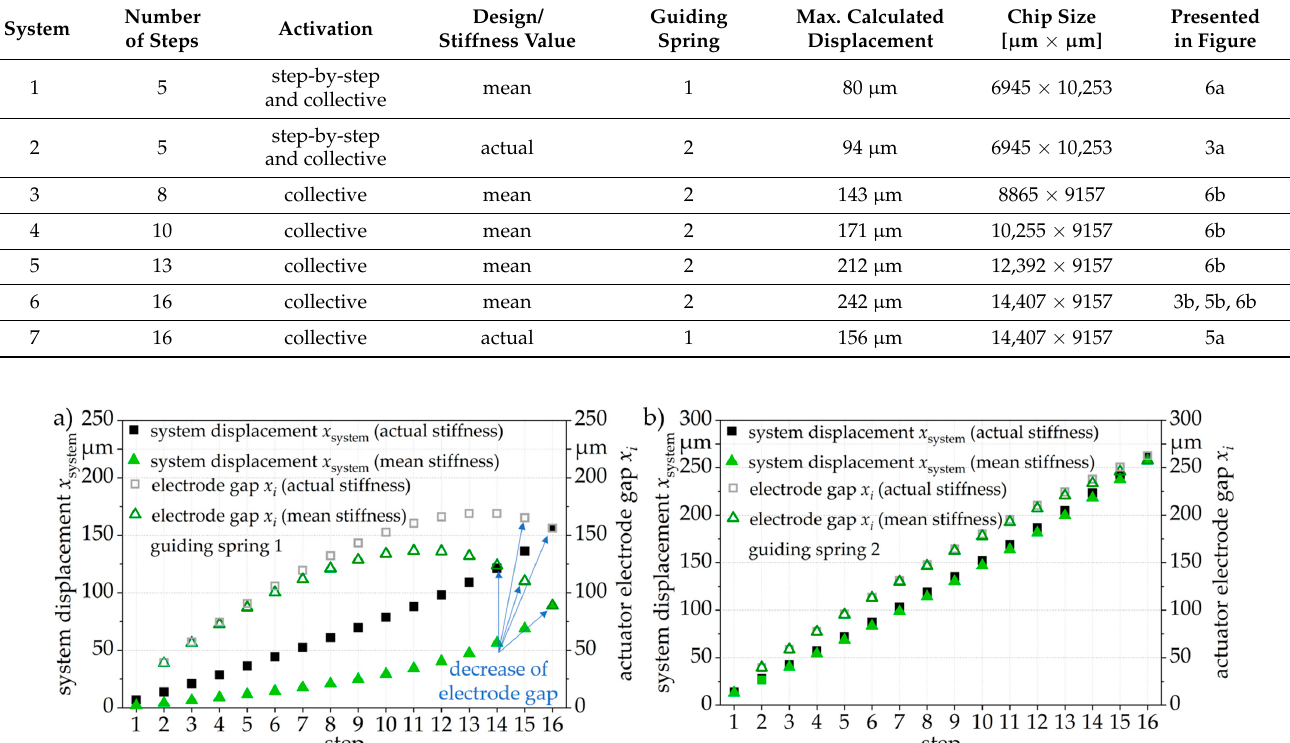
Table 1. Modeled systems, the simulated mean stiffness of guiding spring 1 is k g = 2.9 N/m and the simulated stiffness of the the connecting springs is k i = 4.9 N/m.